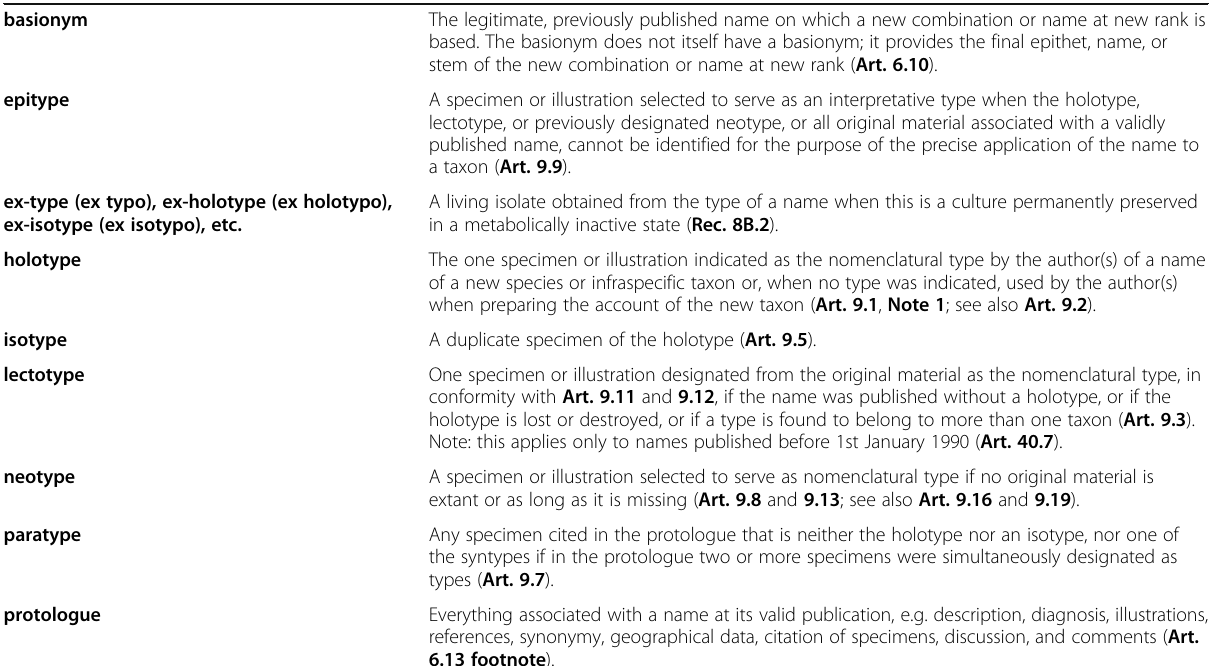
Table 2 Condensed glossary of some definition of terms of the ICNapf used in the manuscript